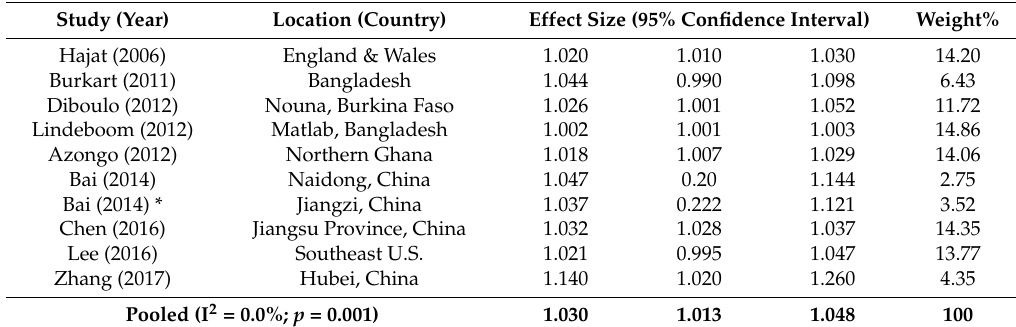
Table 2. Effect size estimates of studies using daily mean temperature for all ‐ cause mortality.